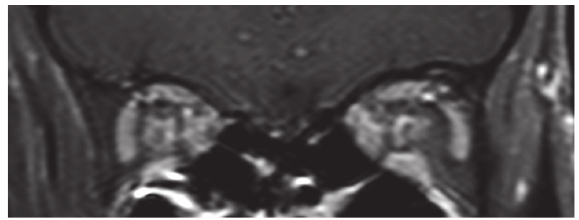
Figure 5: Contrast-enhanced MR images showing marked enhancement of the optic nerve sheath on coronal view (doughnut